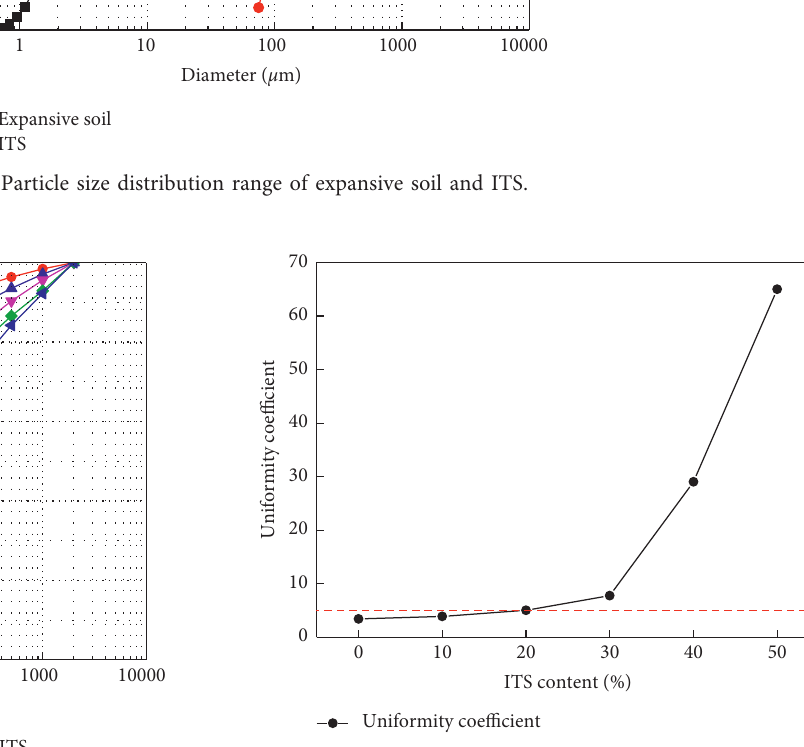
Figure 4: Uniformity coefficient of the ITS treated expansive